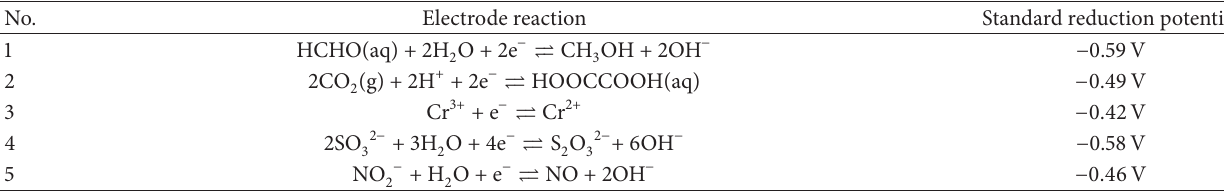
Figure 1: A schematic diagram showing CZTS band alignment with different redox electrolytes. Table 1: Standard reduction potential for selected